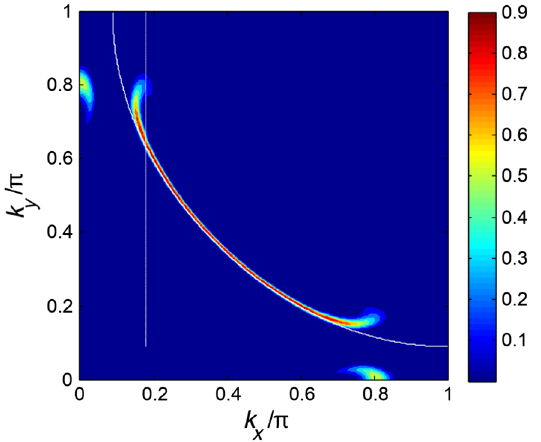
FIG. 4. The spectral weight of the bands (Gaussian broadened with a 10-meV width) at the Fermi level. Parameters are the same as in Fig. 3, which correspond to a doping density p ¼ 0 . 207 . The white line shows the bare Fermi surface. The vertical line marks k x ¼ Q. Note that the tip of the Fermi arc is close to this line; hence, the wave vector connecting the Fermi arcs has length near 2Q, which is the CDW wave vector in our theory. This figure has been symmetrized about the diagonal to account for PDW order in both the x and y